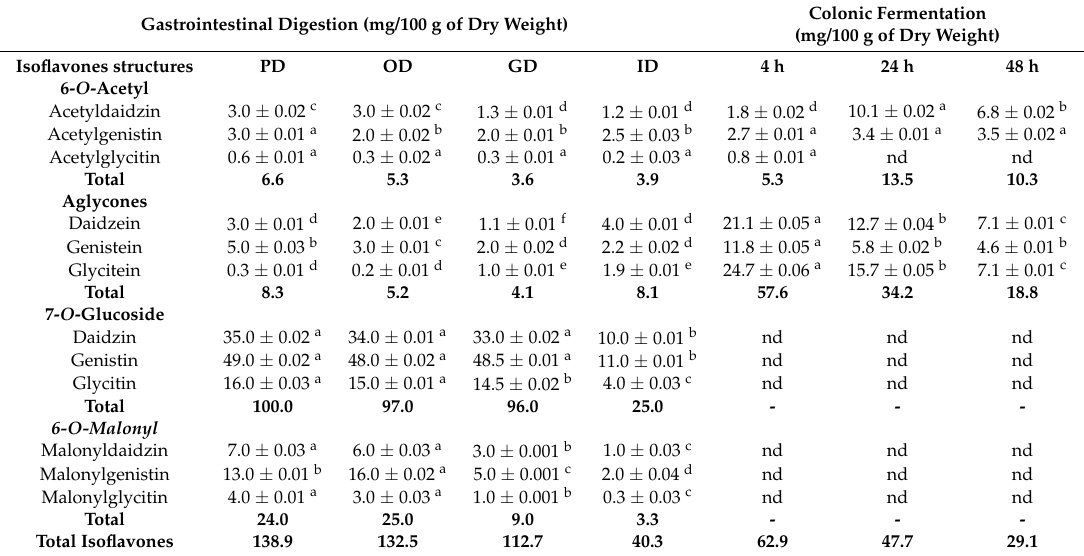
Colonic Fermentation (mg/100 g of Dry Weight)